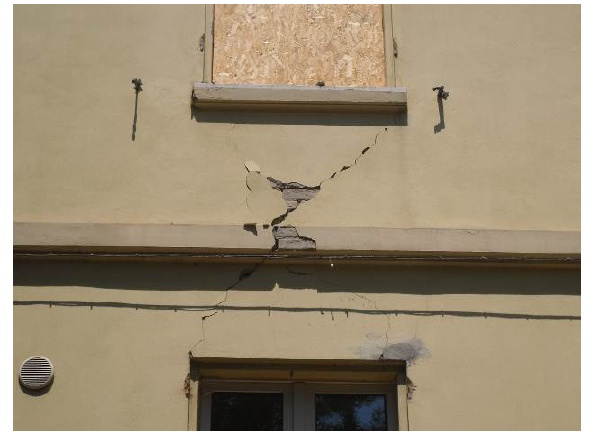
Figure 17. Diagonal shear cracks in spandrel panel.